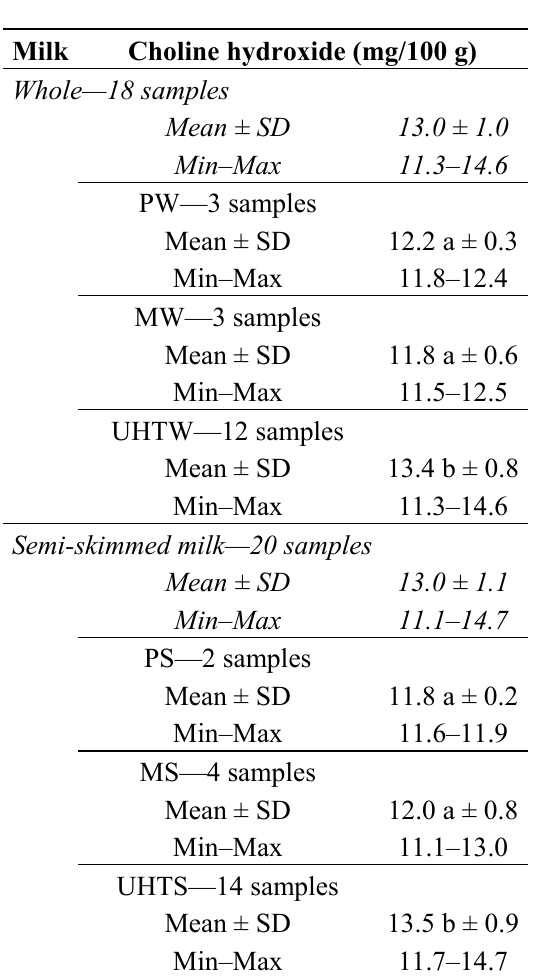
Table 3. Choline hydroxide (mg/100 g) in whole and semi-skimmed commercial Italian milk. Data are shown as the mean with standard deviation (SD) and minimum and maximum